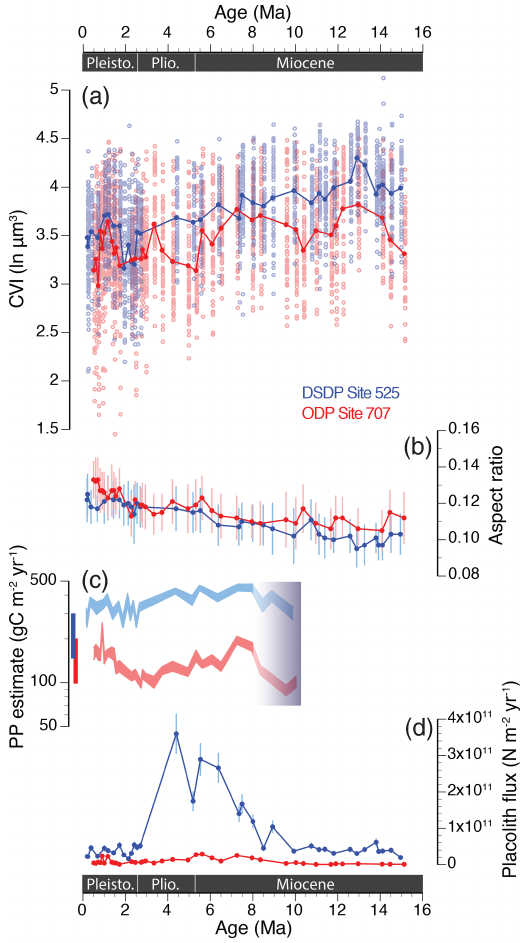
Figure 4. Long-term trends in phenotypic evolution of the Heli- cosphaera genus (including all morphospecies) and paleoenviron- mental estimates at DSDP Site 525 (in blue) and ODP Site 707 (in red) over the past 15Myr. (a) Helicosphaera mean coccolith volume index (CVI; lnµm 3 ) and (b) coccolith aspect ratio (AR). N ≈ 50 per sample. Error bars show 1SD. (c) Primary productivity (PP) estimates (gCm − 2 yr − 1 ; 95% confidence intervals) based on the relative abundance of Florisphaera profunda (% Fp ); cf. Beaufort et al. (1997). Shading between 8 and 10Ma indicates the interval of the first occurrence of this taxon. Bars to the left show the range in modern primary production estimates for the South Atlantic (blue) and the eastern Indian Ocean (red; Antoine et al., 1996; Beaufort et al., 1997; Fischer et al., 2000). (d) Long-term trends in placol- ith fluxes (or burial rates; Nm − 2 yr − 1 ) of species dwelling in the upper photic zone only. Error bars show ± 15% reproducibility as determined from repeat analyses (Bordiga et al.,